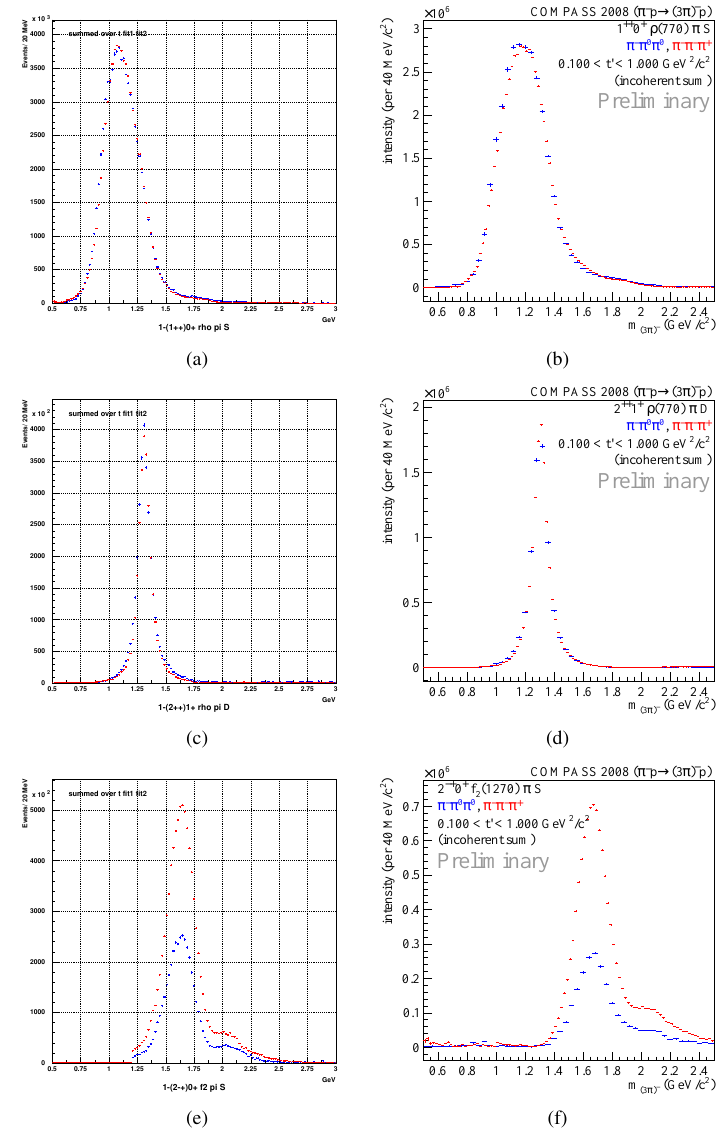
Figure 1: 1 ++ 0 + ρ (770) π S intensity: VES (a), COMPASS (b). 2 ++ 1 + ρ (770) π D intensity: VES (c), COMPASS (d). 2 − + 0 + f 2 (1270) π S intensity: VES (e), COMPASS (f). The π − π − π + data are shown in red, the π − π 0 π 0 data in blue. Waves with isovector ππ isobars (e.g. ρ (770) π waves) are expected to be equal between the neutral and the charged decay modes, i.e. BR( X −